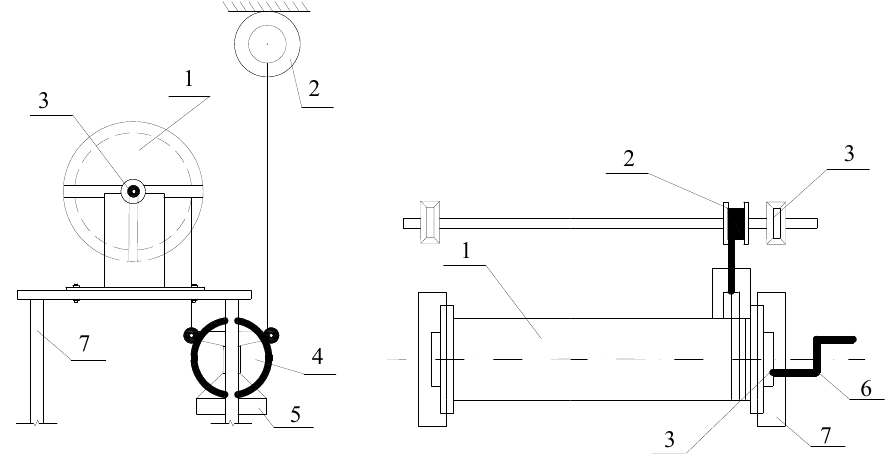
Figure 3. Special installation for winding the steel wrapping on the shell body. 1—Shell fragment; 2—Coil with wire; 3—Coil; 4—Block; 5—Container for load; 6—Handle; 7—Frame. The shell fragments were made of steel sheets 0.5 mm, 0.6 mm and 0.7 mm